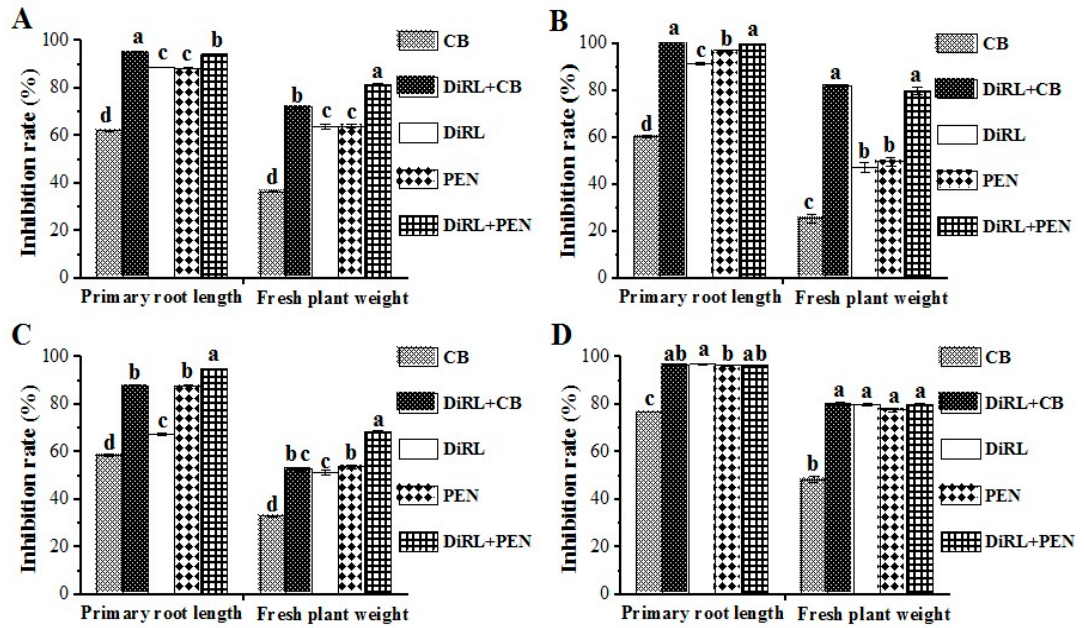
Figure 4. Inhibition rates of dirhamnolipid combined with cyhalofop-butyl or penoxsulam on the primary root length and fresh plant weight of four test dicot weeds at the concentration of 100 mg L − 1 (7d). ( A ) B. pilosa ; ( B ) M. micrantha ; ( C ) A. retroflexus ; ( D ) A. Conyzoides . CB: Cyhalofop-butyl. DiRL + CB: Dirhamnolipid combined with cyhalofop-butyl. DiRL: Dirhamnolipid. PEN: Penoxsulam. DiRL + PEN: Dirhamnolipid combined with penoxsulam. Same letter represent values that are not significantly different at the 0.05 probability level according to Duncan’s multiple range test.